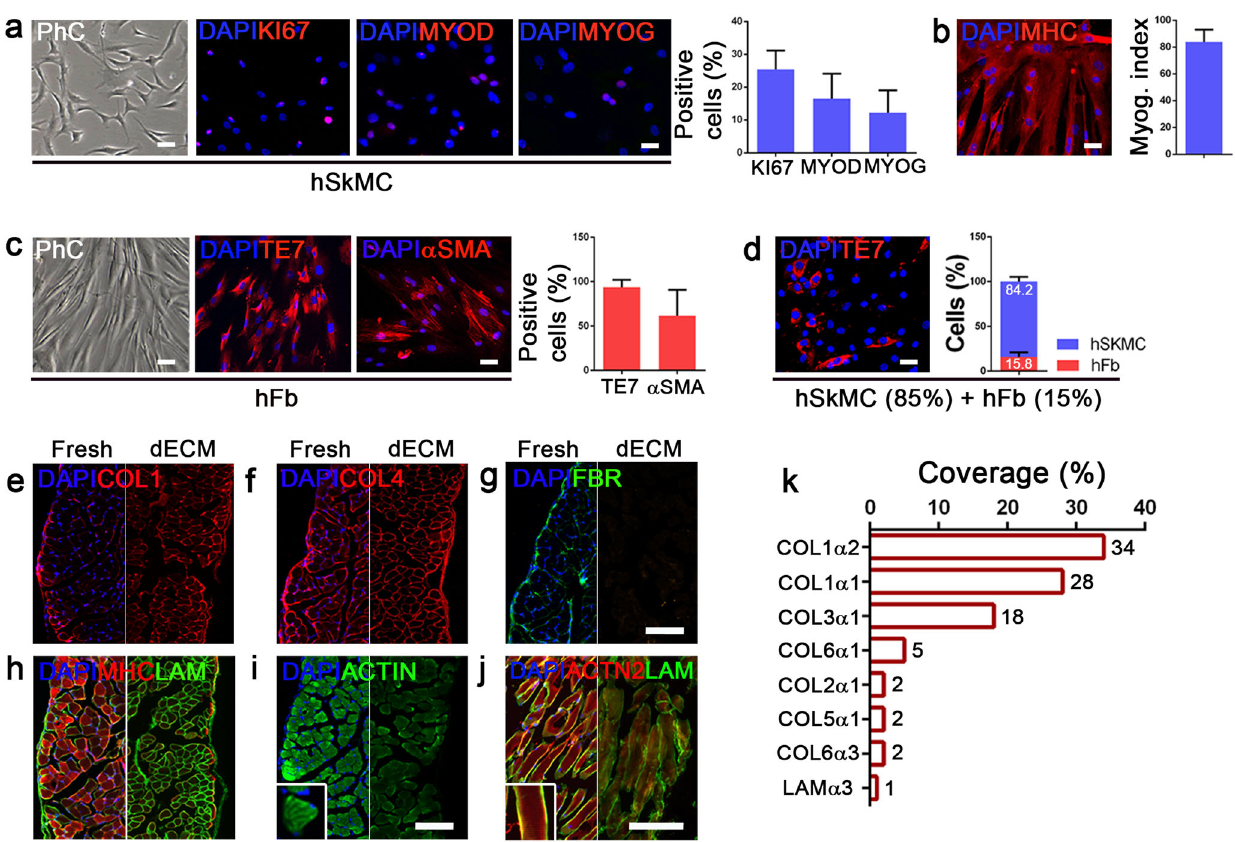
Fig. 1 Diaphragmatic-like construct components. a Human skeletal muscle cells (hSkMC) characterization: immuno fl uorescence and quanti fi cation of cells positive for a proliferation marker (KI67) and myogenic markers (MYOD and MYOG; n = 4, mean ± s.d.). b Immuno fl uorescence of MHC and quanti fi cation of myogenic index ( n = 4; mean ± s.d.). c Human fi broblasts characterization (hFb): immuno fl uorescence and quanti fi cation of TE7 and α SMA positive cells ( n = 4). d Immuno fl uorescence and quanti fi cation of TE7-positive cells in 2D co-cultures of hSkMC (85%) and hFb (15%) after 4 days ( n = 4; mean ± s.d.). e – j Immuno fl uorescence of ECM (Collagen type 1, Collagen type 4, Fibronectin, Laminin) and myogenic (Myosin heavy chain, Actin, sarcomeric Actinin 2) proteins on decellularized scaffolds. k Coverage rate of ECM proteins detected through mass spectrometry analysis ( n = 3). Scale bars: 50 μ